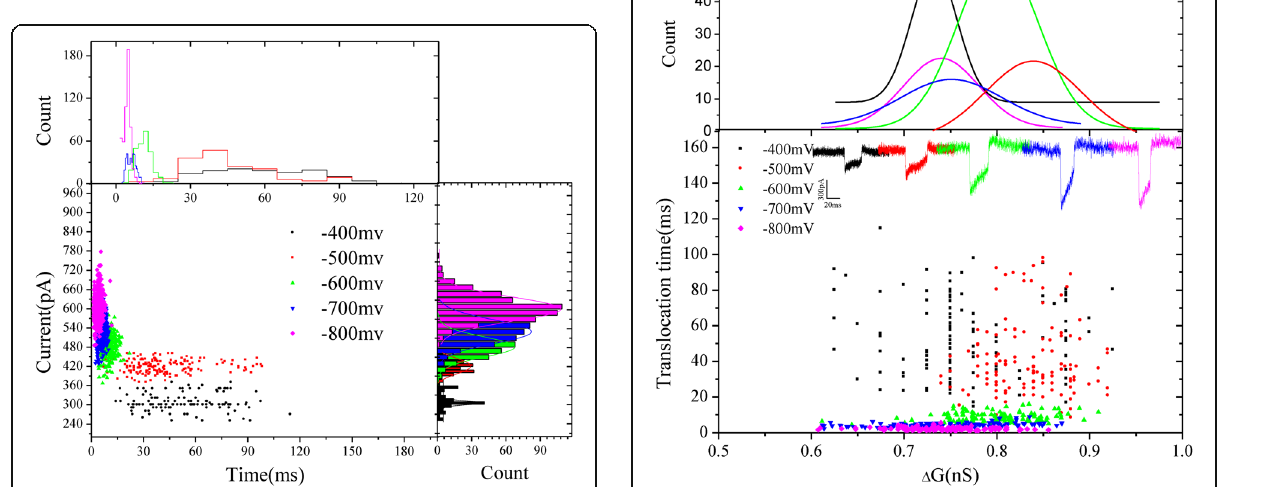
Fig. 5 Two-dimensional scatter plots of current blockage versus events dwell time for each aggregated ABTS (cid:129) + at different voltages. Its corresponding histograms are put on the right and above. All histograms were fitted with Gaussian distribution